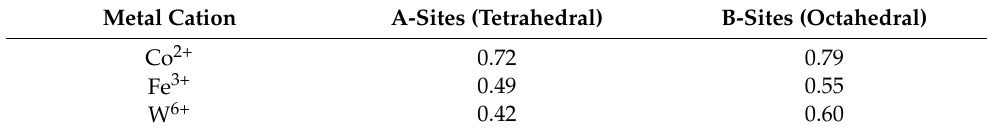
Table 2. Ionic radii (Å) of different metal cations in A-sites (tetrahedral) and B-sites (octahedral) [29].